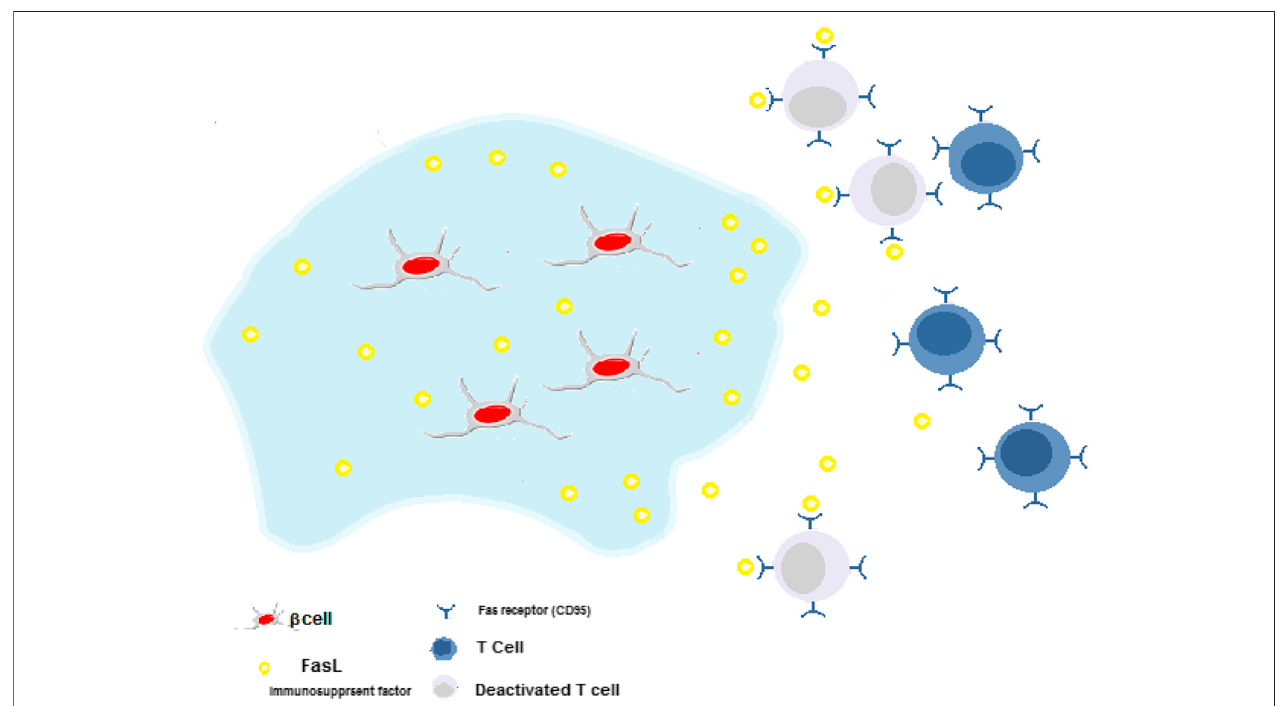
FIGURE 5 | Immune-suppressive hydrogels for delivery of β -cells. Cytotoxic T cells around transplantation site deactivated by the release of FasL. This process induces more pancreatic cell survival.